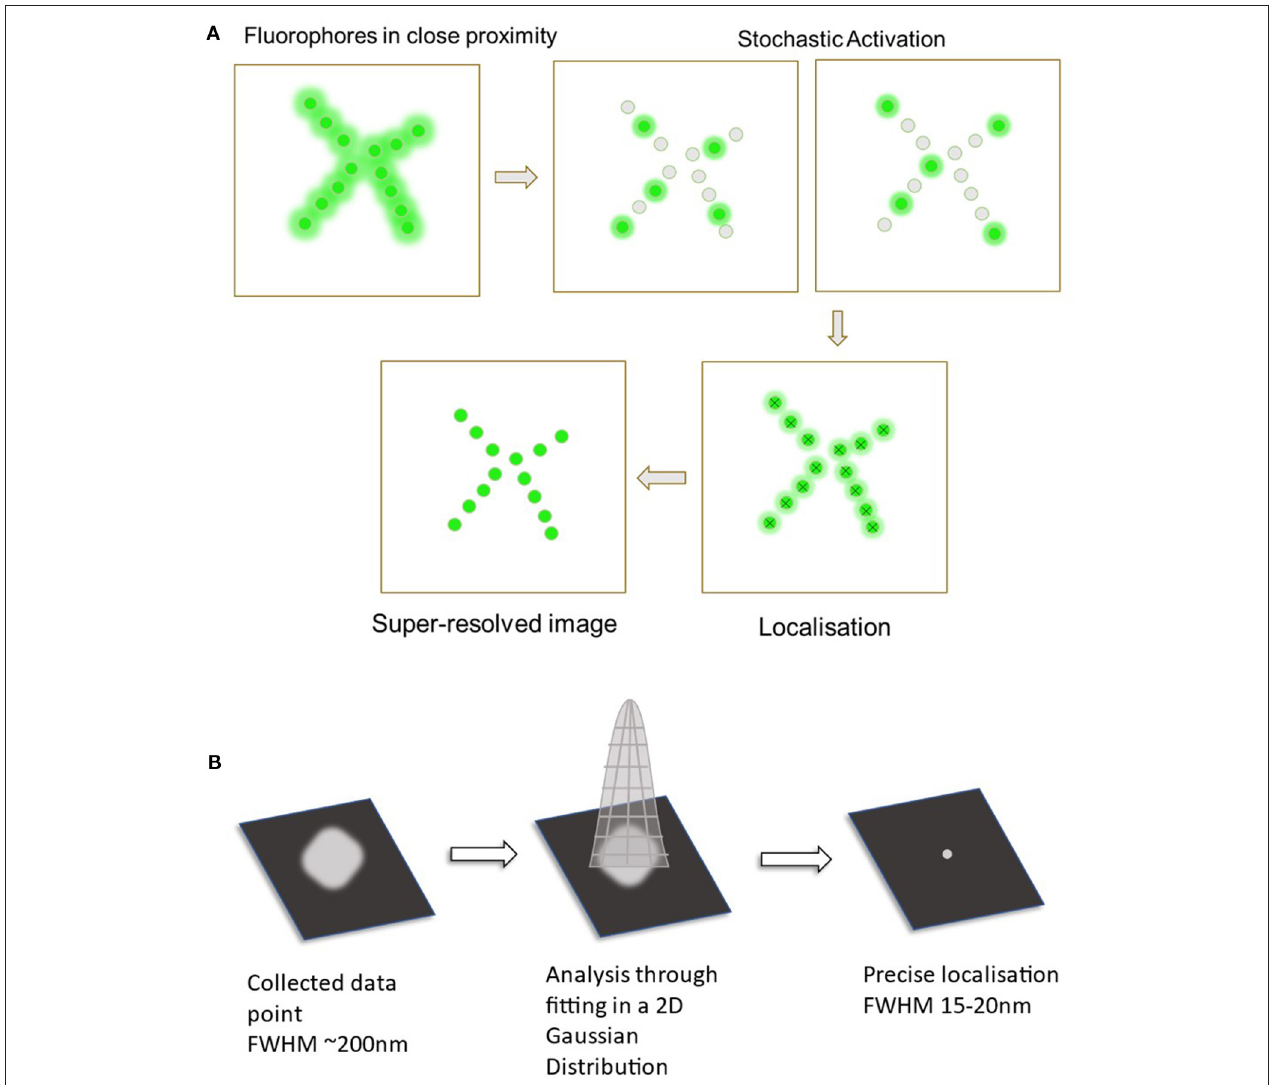
FIGURE 1 | Diagram displaying the process of single molecule localization microscopy (SMLM). (A) The primary steps in SMLM starts off with the fluorophores in a densely packed area. These are then stochastically activated to spatially separate the fluorophores. Data from all of the probes are collected and analyzed to localize all the points. This now creates the final super-resolved image. (B) Analysis through fitting to a 2D Gaussian distribution. Collected fluorescent signal (Full width at half maximum ∼